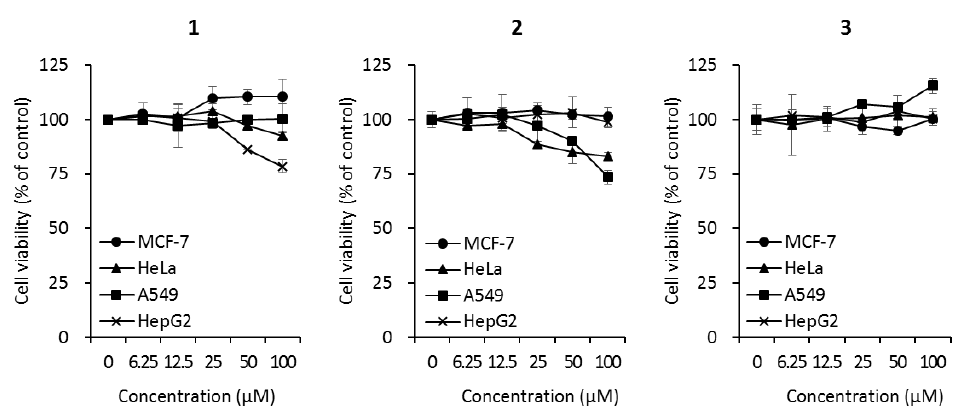
Figure 3. Cytotoxicity of compounds 1 – 3 against human cancer cell lines (MCF7 breast cancer cells, HeLa cervical cancer cells, A549 lung cancer cells, and HepG2 liver cancer cells). Cells were treated with compounds at the indicated concentrations. After 72 h of incubation, cell viability was analyzed according to the manufacturer’s instructions using the EZ-CyTox cell viability assay kit.